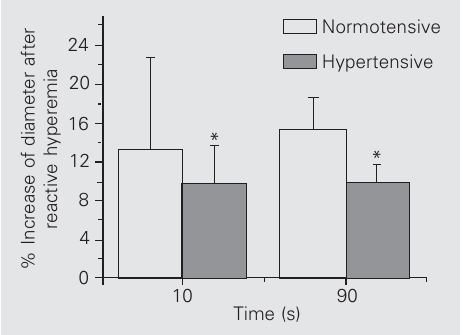
1. Flow-mediated endo- thelium-dependent vasodilation in response to reactive hyper-